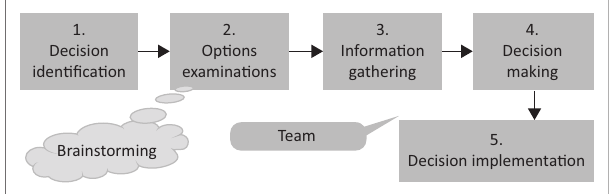
FIGURE 1: Decision-making